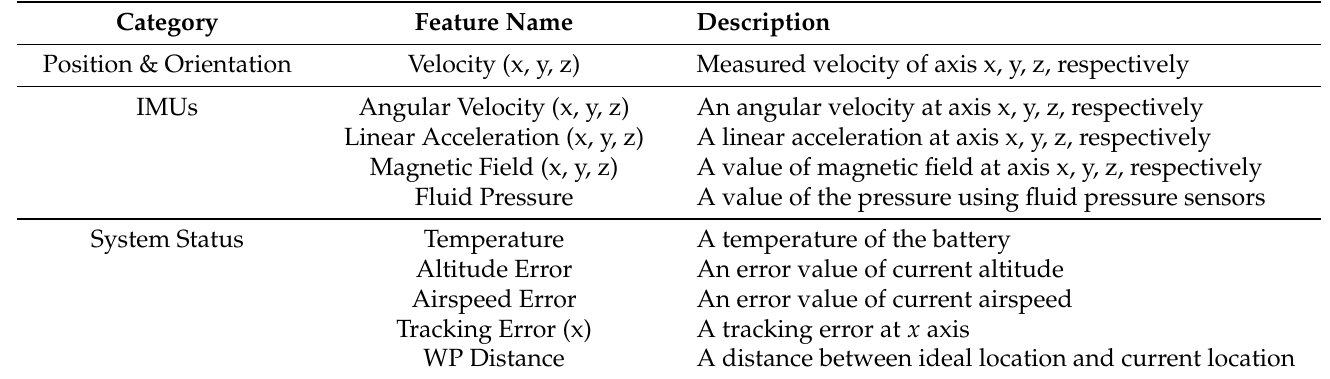
Table 2. Features extracted from the ALFA dataset.